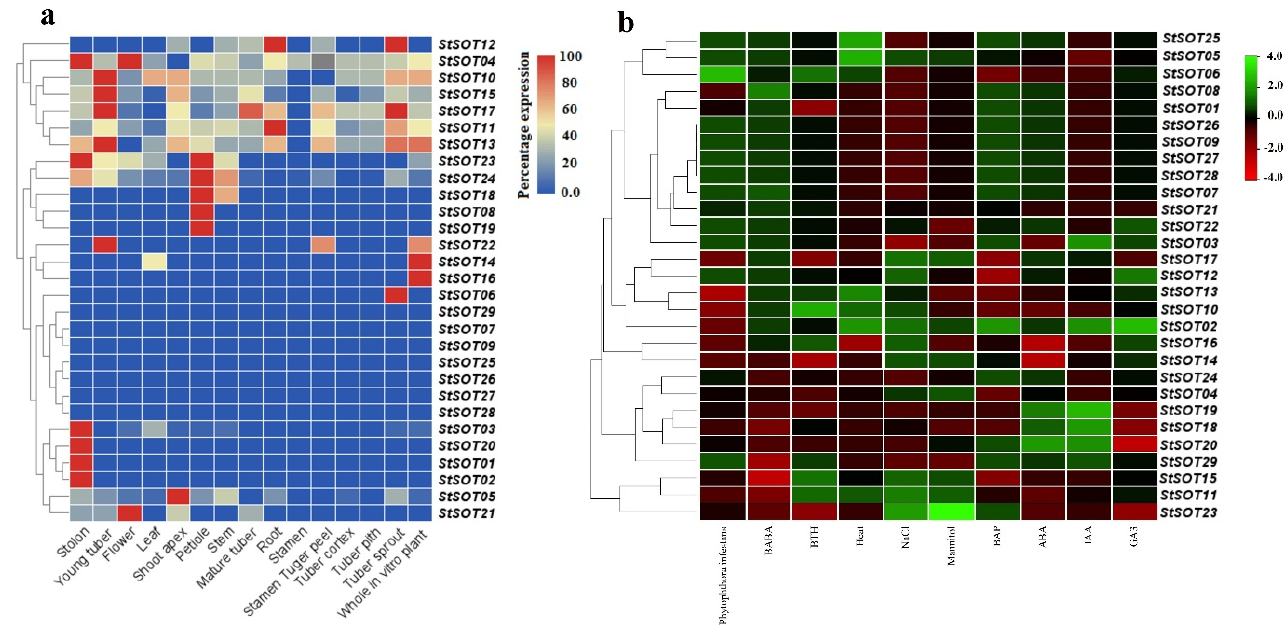
Figure 9. Tissue-specific ( a ) and stimuli-induced gene expression analysis ( b ) of StSOT genes in the potato genome based on RNA-Seq data reported by the potato genome sequencing consortium.